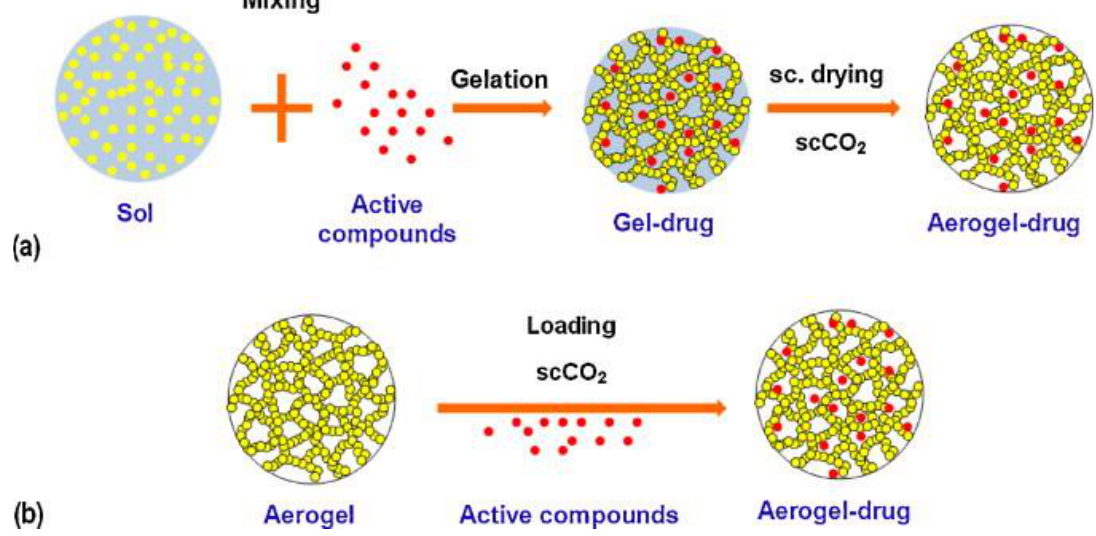
Figure 4. Different strategies for incorporating AIs into aerogels: ( a ) the sol – gel process (co-gelation); ( b ) in the aerogel matrix by supercritical impregnation post-treatment method. Reprinted from Carbohydrate Polymers, 86, García-González et al., Polysaccharide-based aerogels — Promising biodegradable carriers for drug delivery systems, 1425 – 1438, Copyright (2011), with permission from Elsevier.